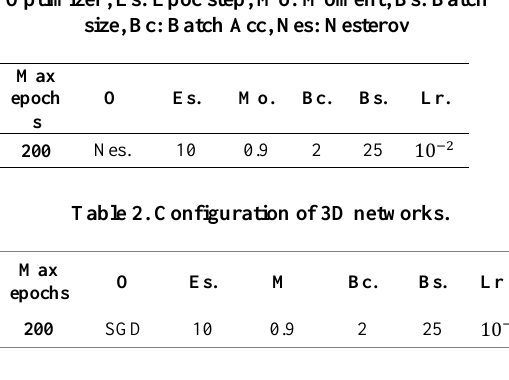
Table 1. Configuration of 2D CNN’s. Moment: momentum, acc: accumulation, lr: learning rate. O: Optimizer, Es: Epoc step, Mo: Moment, Bs: Batch